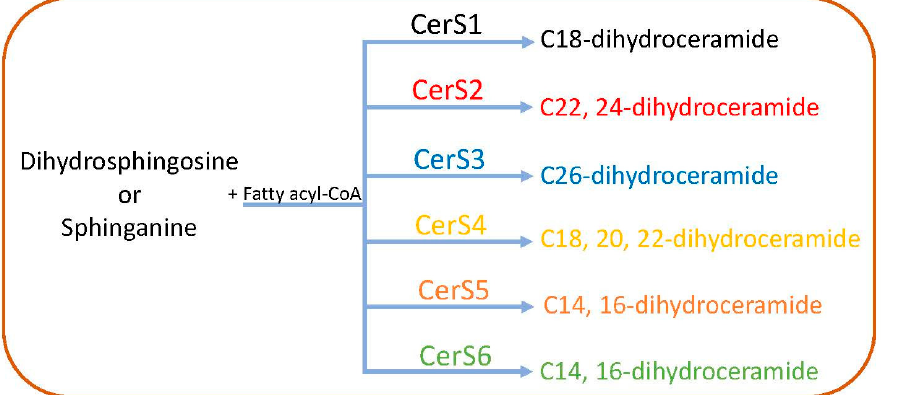
Figure 3. Specificity of ceramide synthases. There are six ceramide synthases that synthesize dihy- droceramides with specific fatty acid chain lengths. Ceramides are formed from sphinganine or di- hydrosphingosine by the attachment of acyl groups to the sphingosine backbone by ceramide syn- thases. Sphingosine generated by CDases can be transported to the ER and can be used in the syn- thesis of ceramides [25,26]. Sphingosine can be phosphorylated to sphingosine-1-phosphate (S1P) by two kinases, sphingosine kinase 1 and sphingosine kinase 2 [27]. At plasma mem- brane, S1P can be dephosphorylated by lipid phosphate phosphatases (LPP1-3) and cytosolic S1P can be dephosphorylated by S1P-specific phosphatases (SPP1 and SPP2) [26,28]. S1P